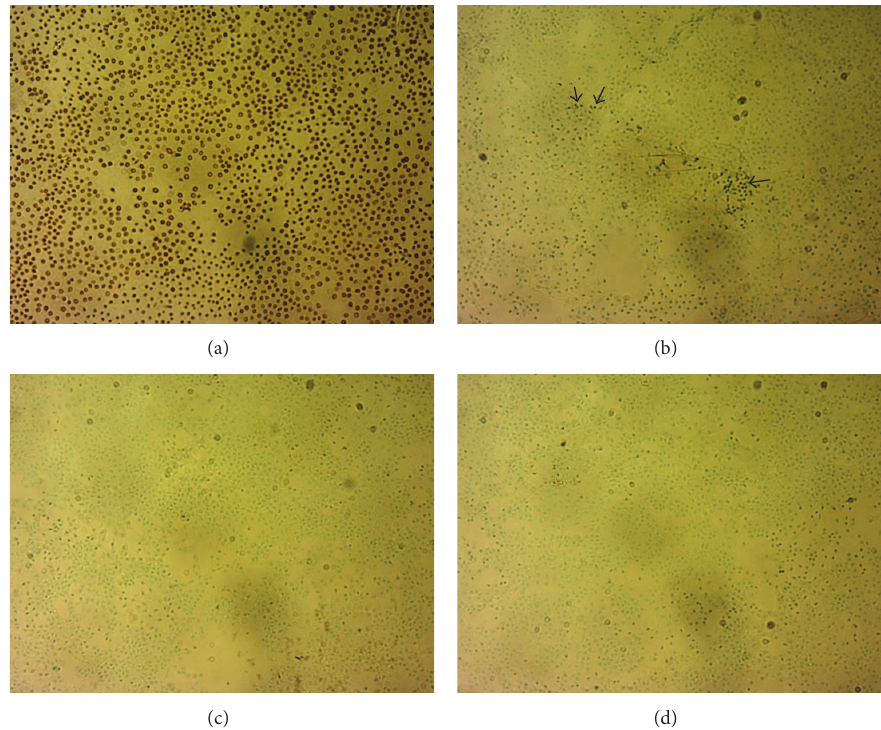
Figure 4: Cell apoptosis after preservation of preloaded DMEK lenticules. (a) Induced apoptosis on the control sample at 100x magnification. (b) C1 showed mild apoptosis whereas ((c) and (d)) C2 and C3 did not show any apoptosis after preservation and the nucleus was visible with methyl green counterstain at 100x magnification. Hence it was determined that the preservation of the DMEK lenticule in a cartridge for 4 days does not have any drastic damage on the endothelial